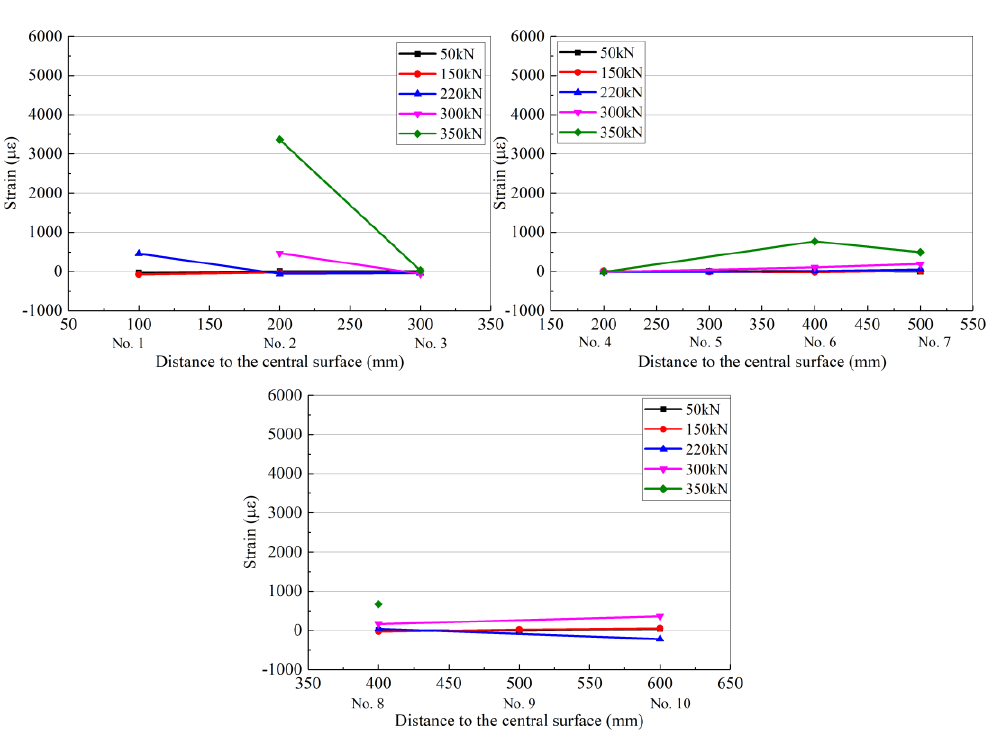
Figure 10. Strain distribution of concrete for RC-control beam.